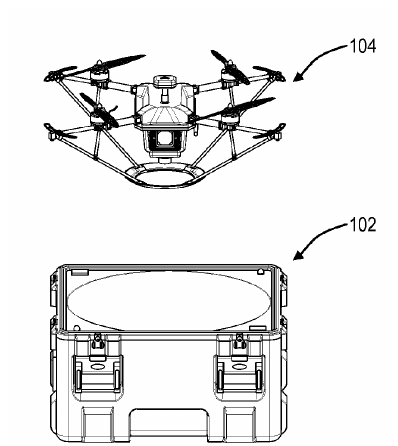
Figure 26. Landing station for an unmanned aerial vehicle with a funnel for all legs [76] by Skycatch Inc. 102, landing station; 104, UAV.